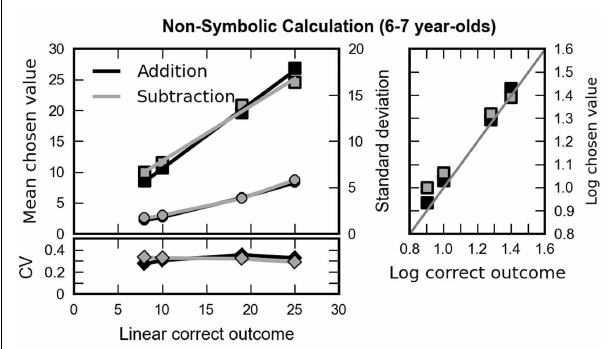
FIGURE 3 | Distribution of the children’s choices across the six proposed results, averaged over all arithmetic problems, separately for addition (left column) and subtraction (right column) .The children’s responses were not distributed randomly but depended on the range of response alternatives presented (high or low range shown as black squares and gray squares, respectively). Responses were centered around the values that were closest to the correct outcome (fifth for low range and second for high range).